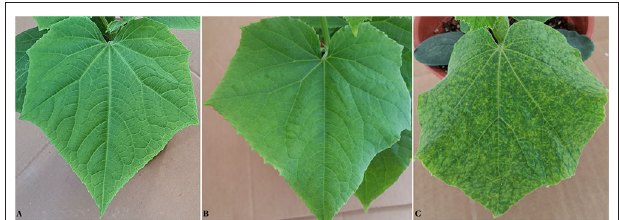
FIGURE 1 | Healthy and Cucumber vein yellowing virus (CVYV)-infected cucumber leaves. Cucumber plants were mechanically inoculated at the cotyledon to one-true-leaf stages. A second inoculation was performed 3 days after the first one. The inoculated cucumber seedlings were then kept in a growth chamber with temperature control set at 30/25 ◦ C (day/night) with a 16h light/8h dark photoperiod for 3 weeks and observed every 2 days. The plants were evaluated for symptom development at 15 days after the first inoculation (dpi). Control plants were treated with buffer without virus in a similar manner. (A) Leaf of an uninoculated control plant, (B) leaf of a Cucumber vein yellowing virus (CVYV)-inoculated-resistant plant, and (C) leaf of a CVYV-inoculated-susceptible plant.